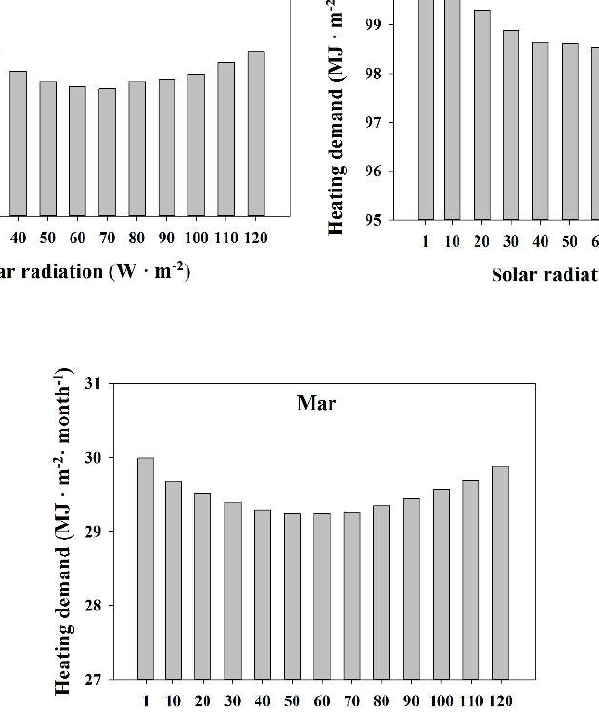
Figure 16. Monthly energy consumption of greenhouse with different solar radiation values.